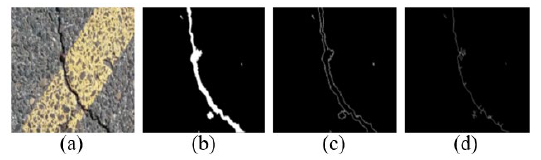
Figure 8. The step of processing for crack measurement: (a) the original crack, (b) the detected crack area, (c) the edge of the crack, and (d) the skeleton of the crack.